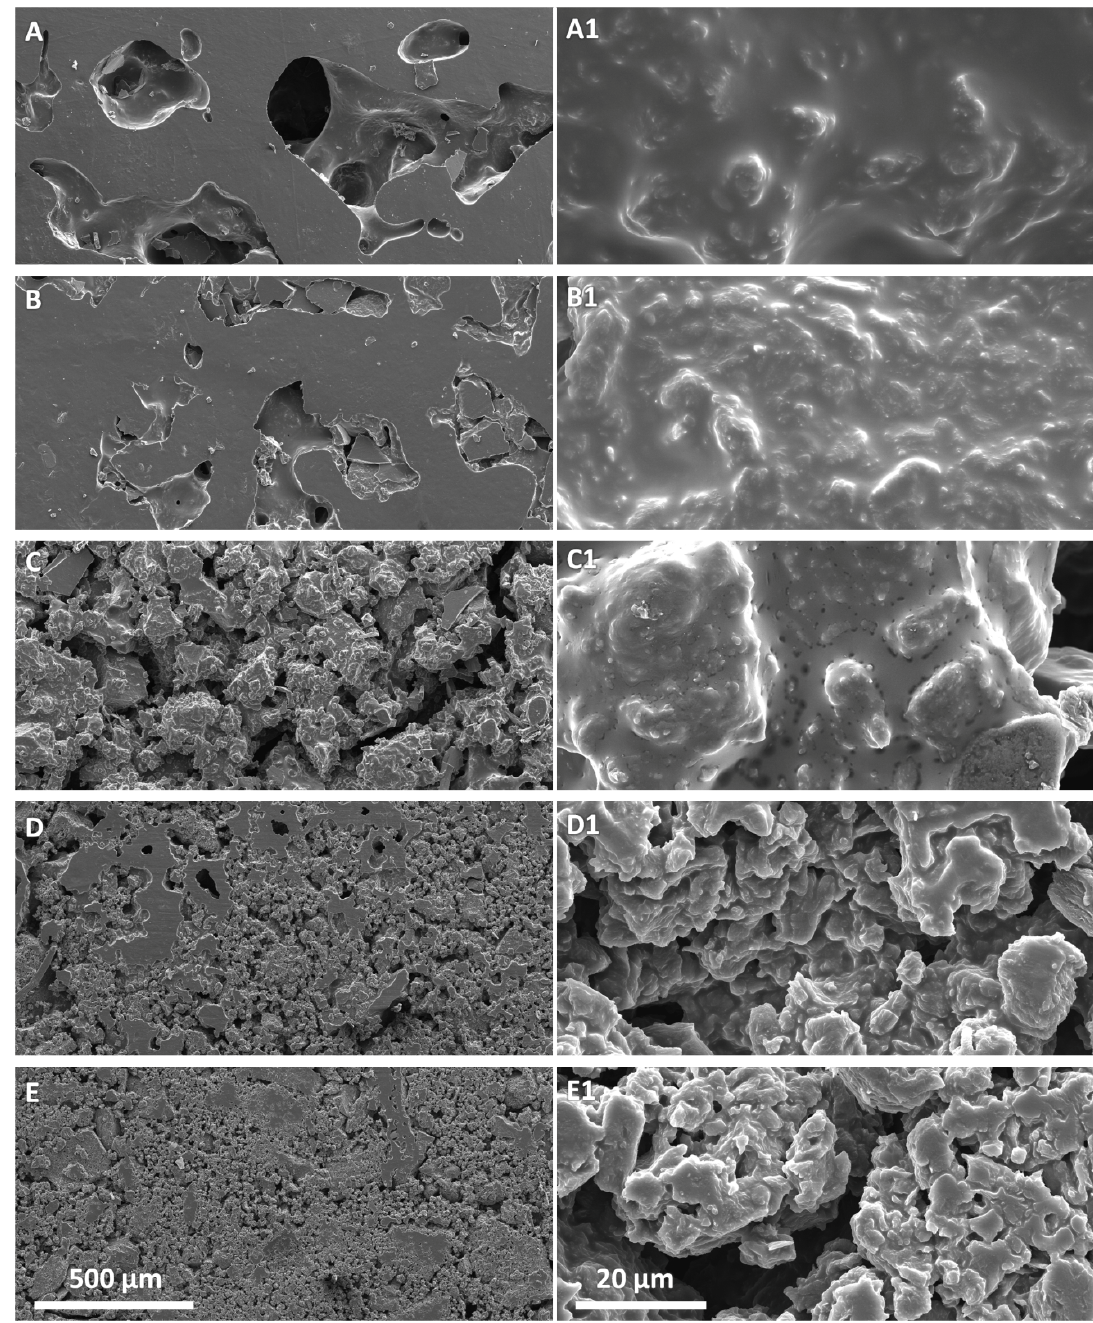
Figure 5. Scanning Electron Microscopy (SEM) micrographs at di ff erent magnification of the nanocomposite composed by PK30-Gly-Gly and lrGO at di ff erent weight percentage. ( A , A1 ) 4 wt. %, ( B , B1 ) 5 wt. %, ( C , C1 ) 6 wt. %, ( D , D1 ) 7 wt. %, and ( E , E1 ) 8 wt. %. Left pictures scale bar 500 µ m, right pictures scale bar 20 µ m.